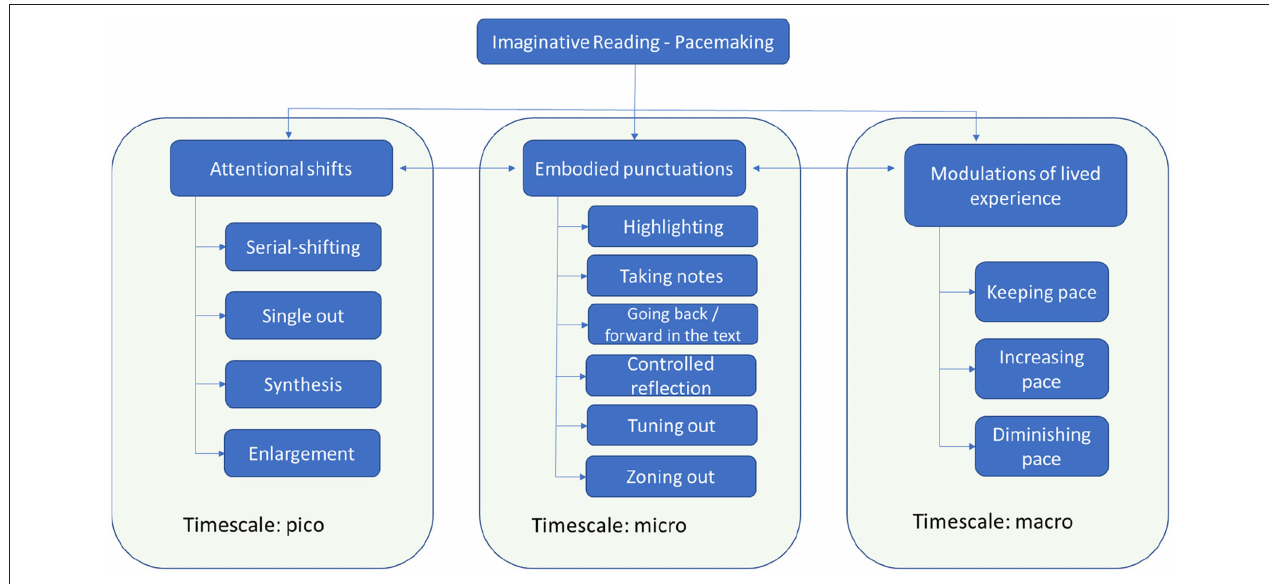
FIGURE 2 | General model of pacemaking in imaginative reading. The model illustrates which timescale relates to specific categories under